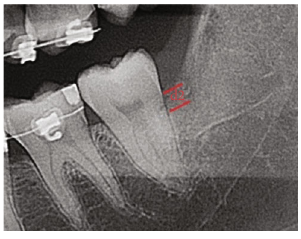
Figure 2: Data were measured at 3 months after surgery (d2).